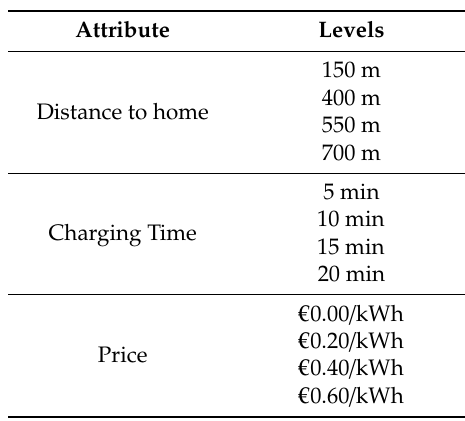
Table 1. Choice experiment parameters and Table 1 . Choice experiment parameters and levels .